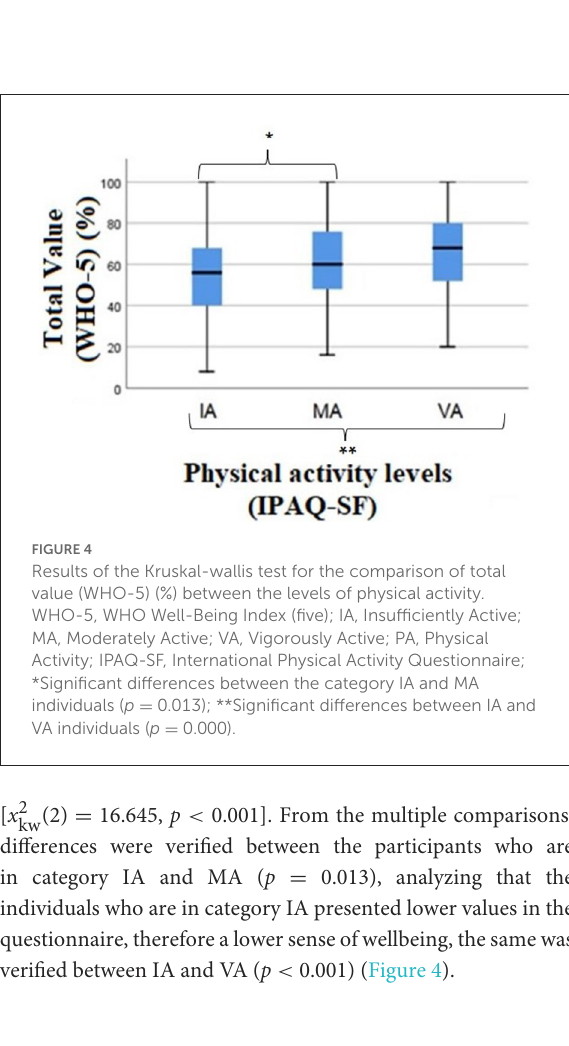
[ x 2 (2) = 16.645, p < 0.001]. From the multiple kw